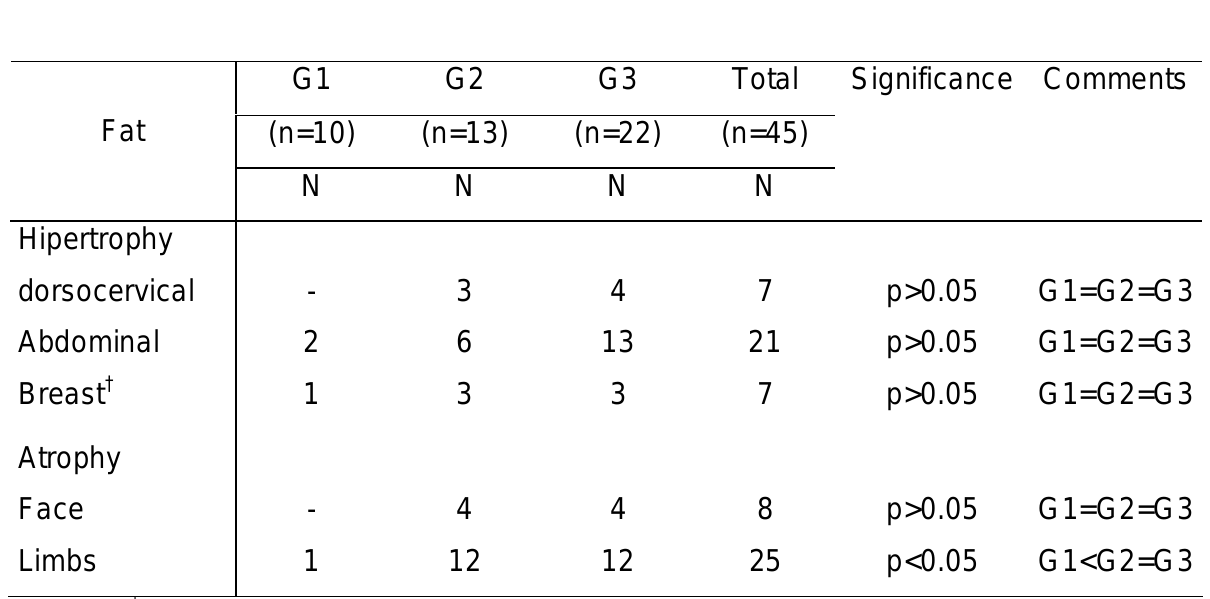
Table 2. Distribution of the 45* HIV-1 infected subjects, according to the study group, the presence of dorsocervical, abdominal and breast † fat accumulation and the presence of lipoatrophy in the face, upper and lower